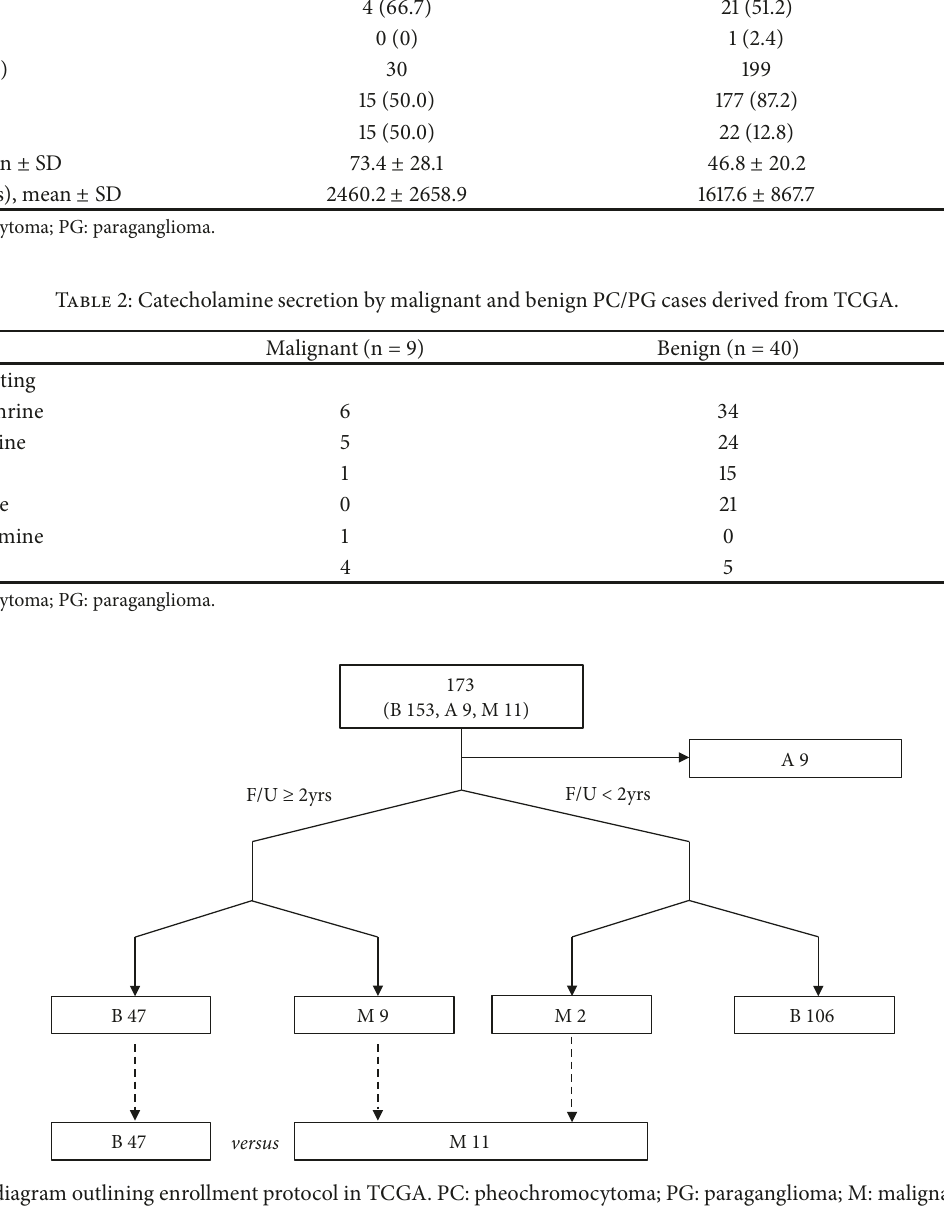
Figure 1: Flow diagram outlining enrollment protocol in TCGA. PC: pheochromocytoma; PG: paraganglioma; M: malignant; A: